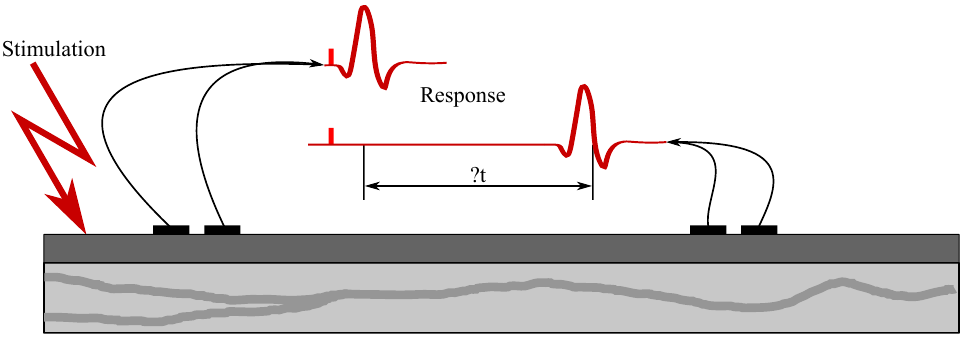
Figure 5. Sample ENG